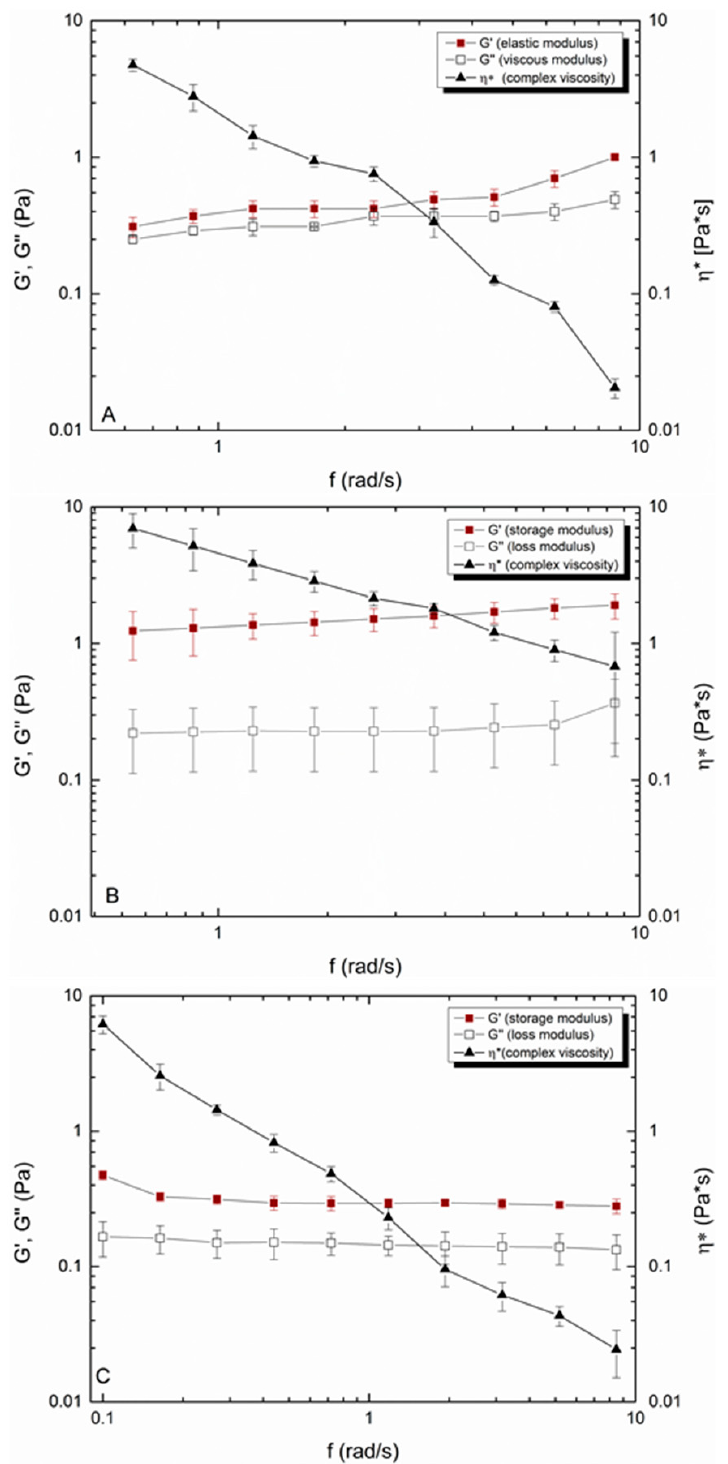
Figure 2. Comparison of the rheological properties of UWS from healthy volunteers ( A ), UWS RT from patients receiving radiotherapy ( B ) and the HA 0.25% ( w / w ) ( C ).